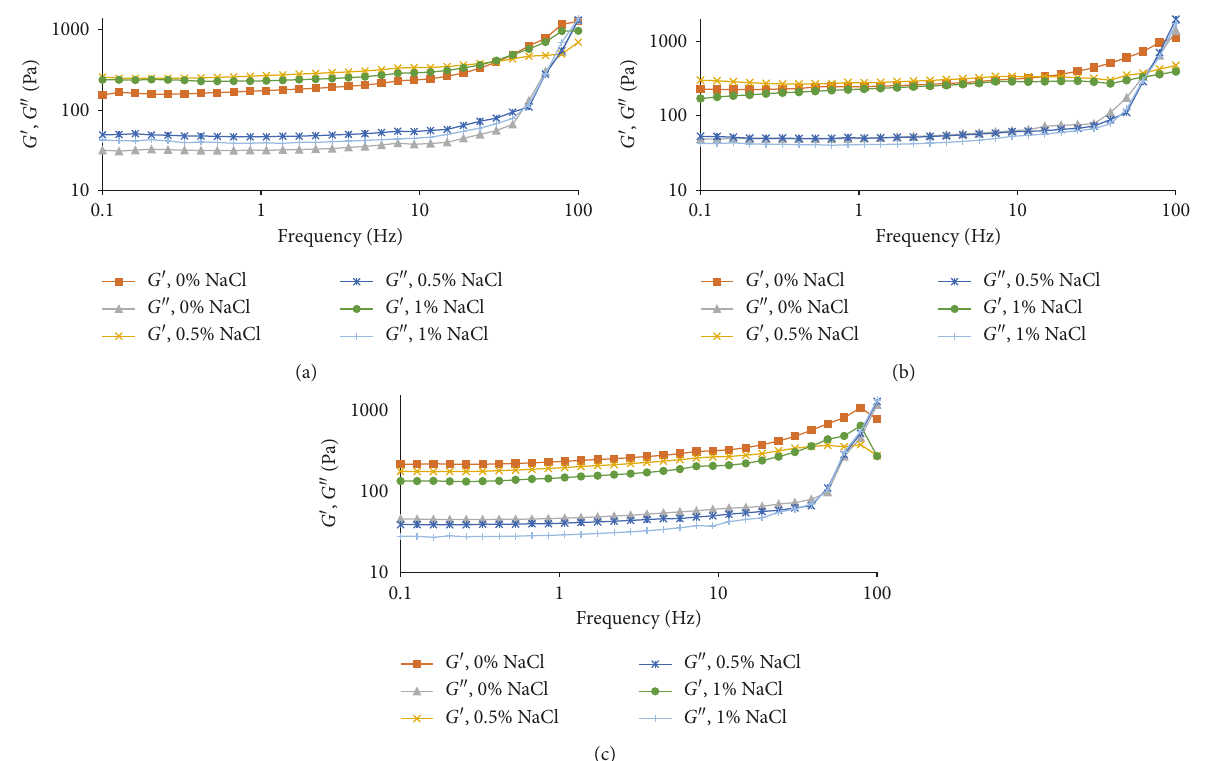
Figure 3: Effect of NaCl and basil seed gum concentration on storage and loss moduli (in frequency sweep test) of egg albumin foams supplemented with 0 (a), 0.1 (b), and 0.3% (c) basil seed gum.